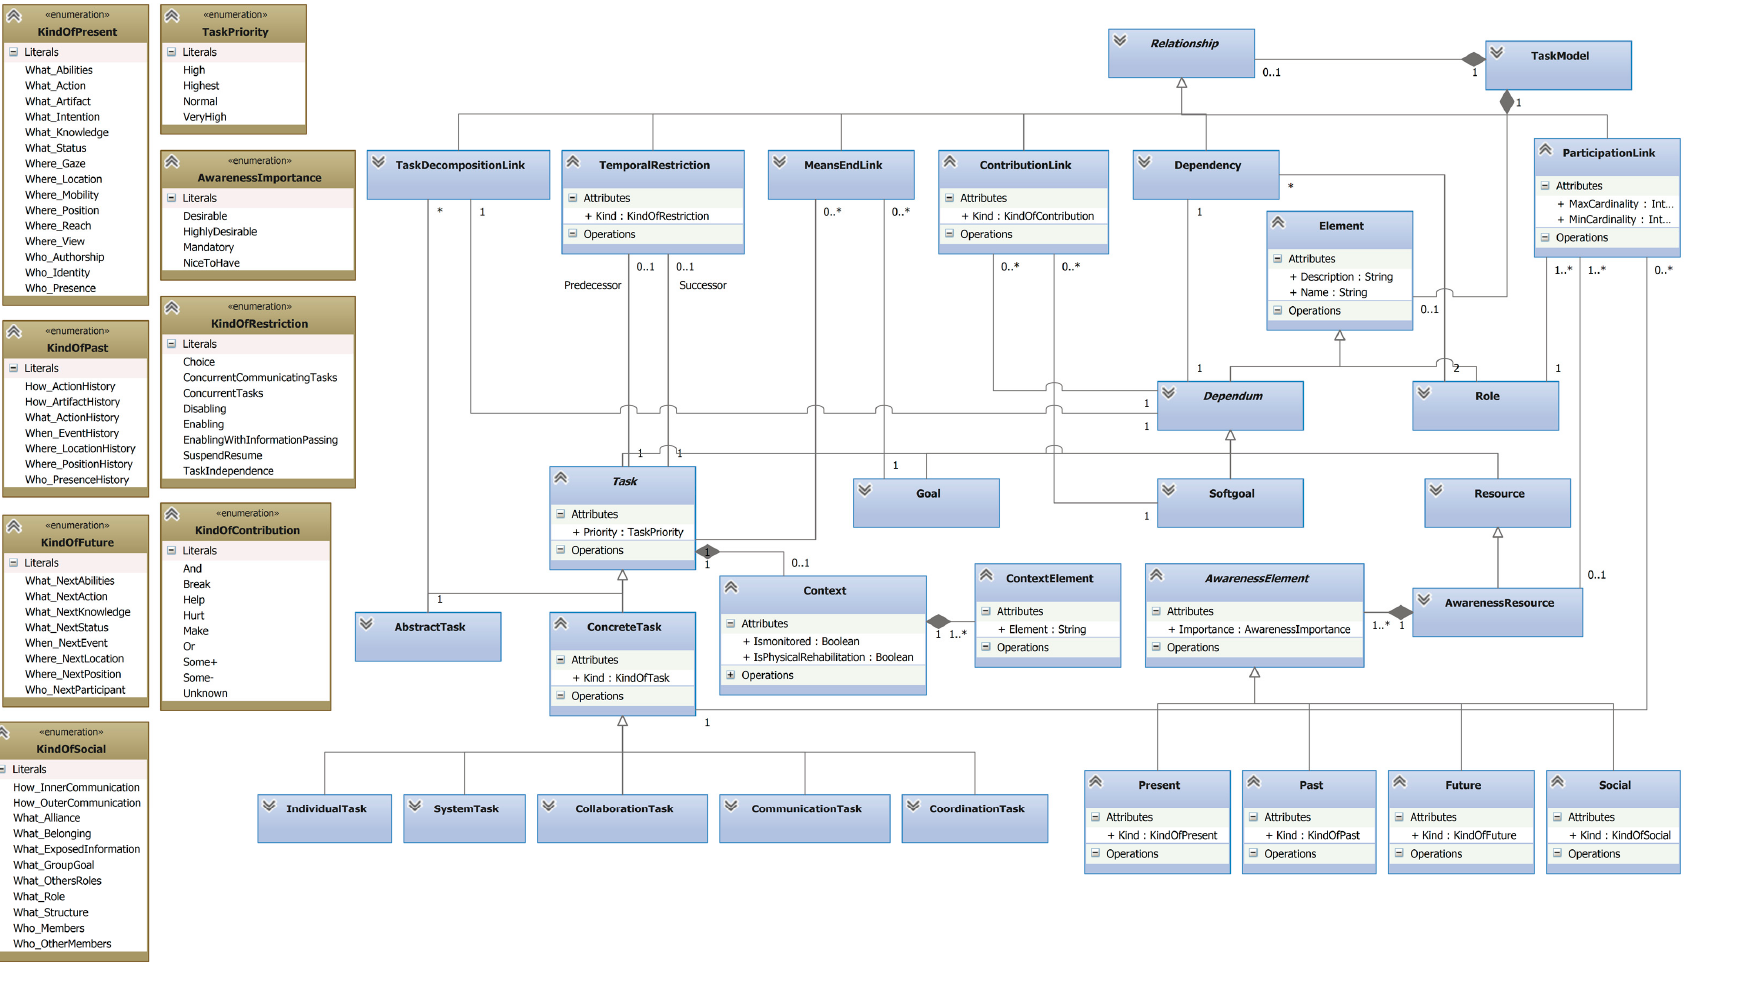
Figure 2. Bio-inspired task 1